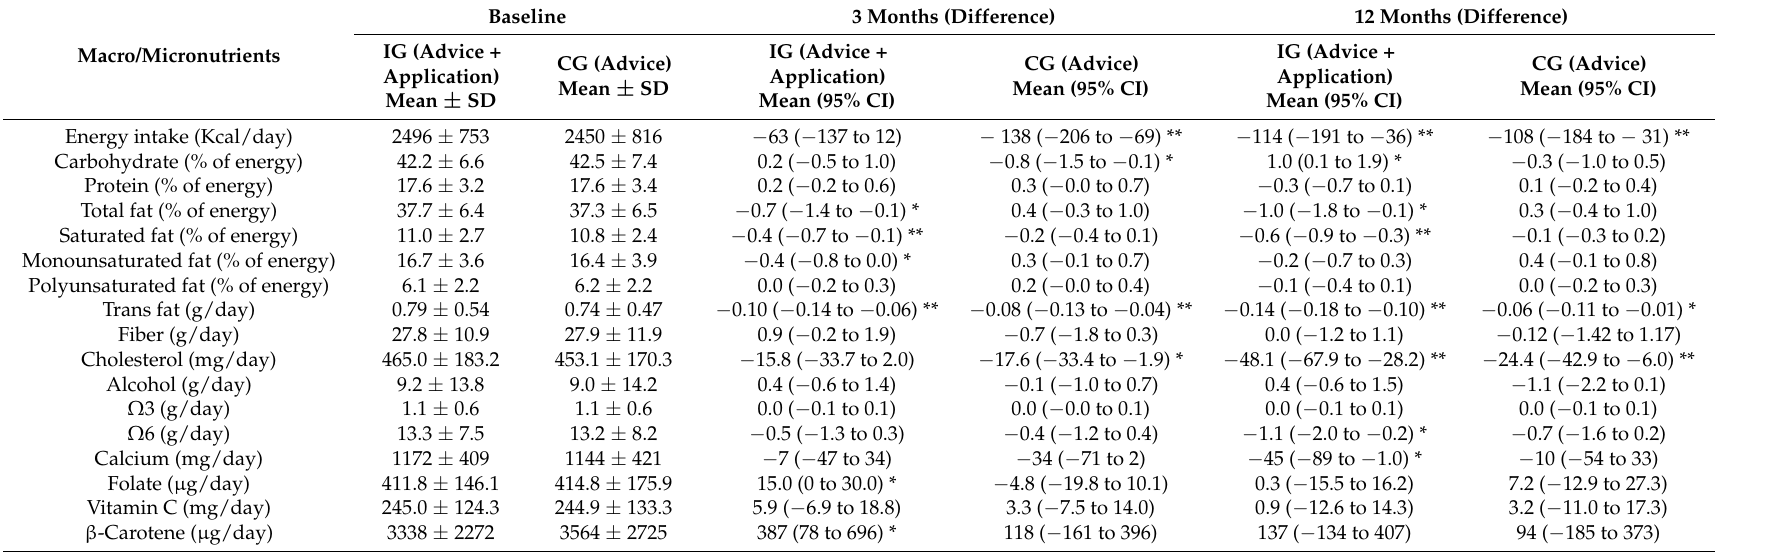
Table 2. Changes in macro and micronutrients from baseline to 3 and 12